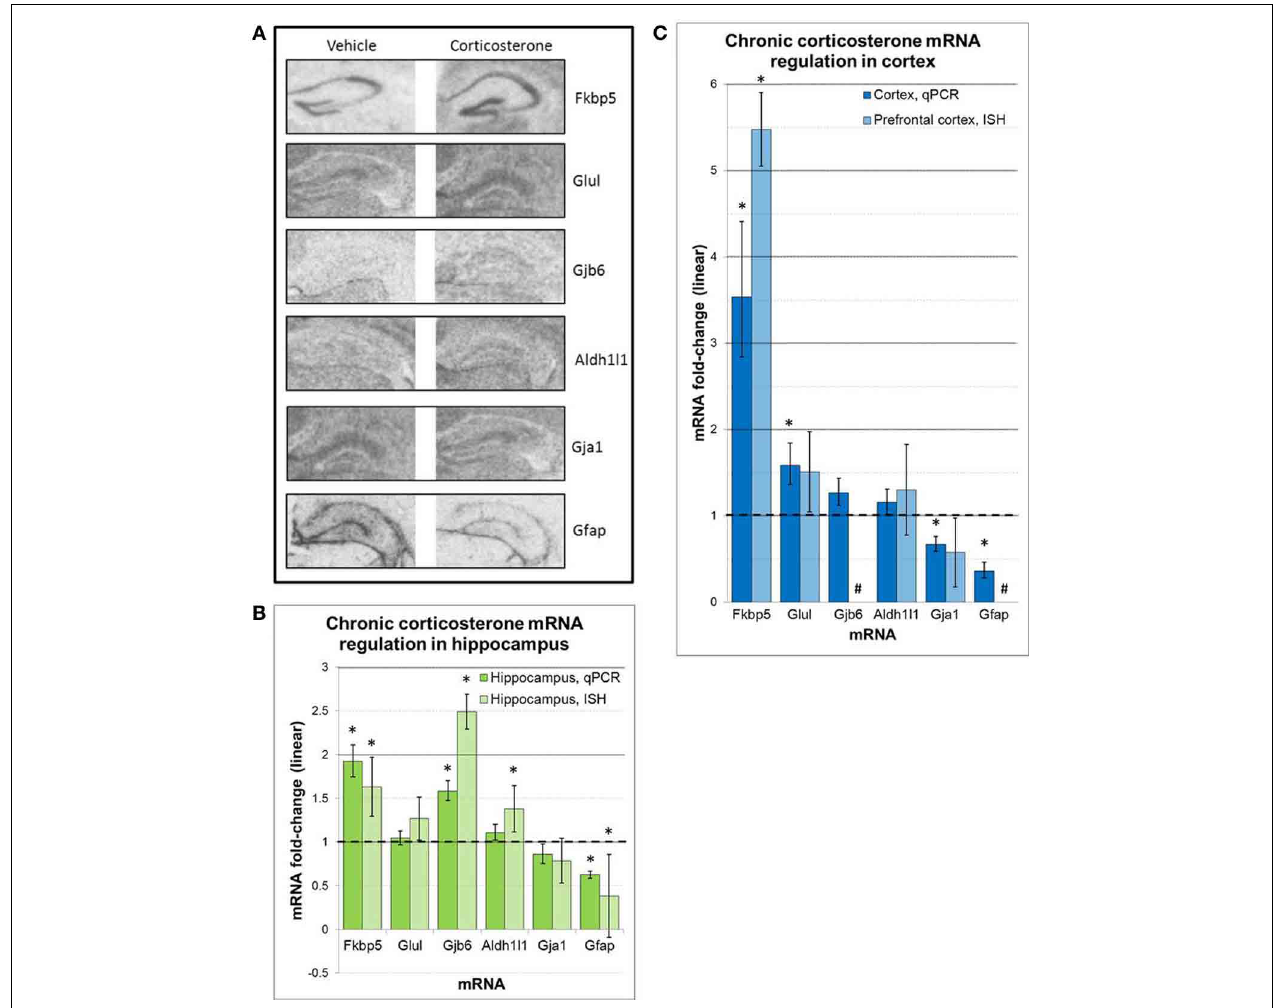
FIGURE 6 | ISH measures of select mRNAs confirm chronic corticosterone regulation and reveal mRNA expression patterns consistent with pan-astrocyte marker Aldh1l1 (A). Representative images of in situ hybridization data for select mRNAs in hippocampus.